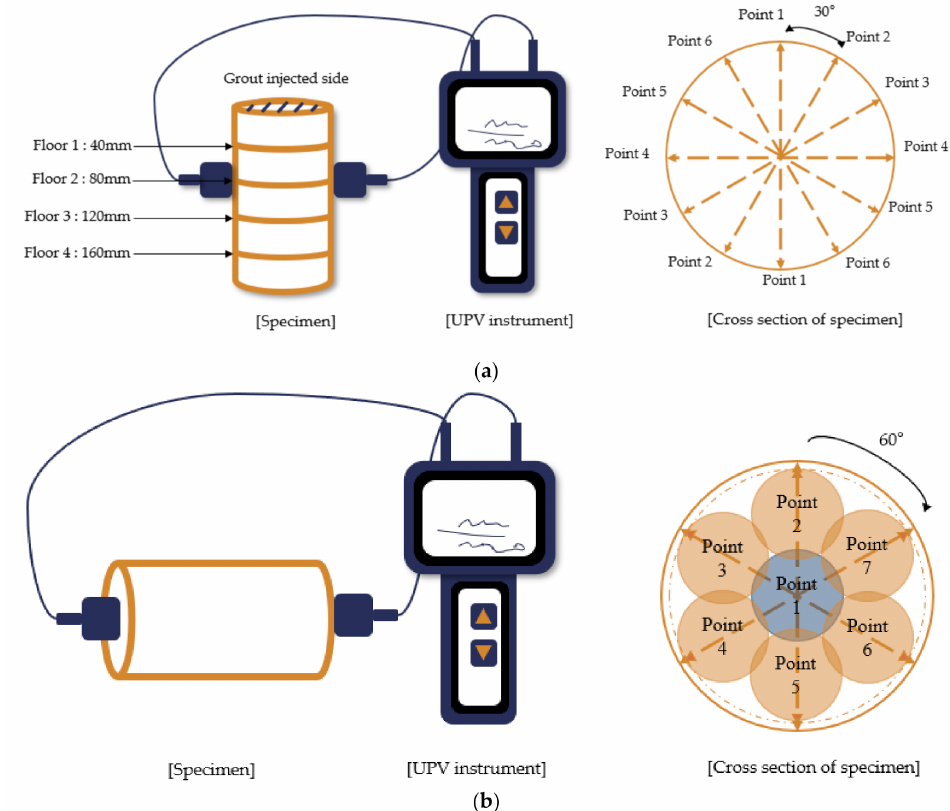
Figure 2. Setup for ultrasonic pulse velocity measurement: ( a ) Horizontal and ( b )